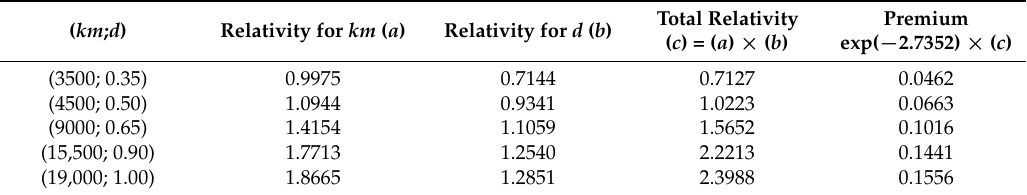
Table 11. A simple PAYD price structure based on model